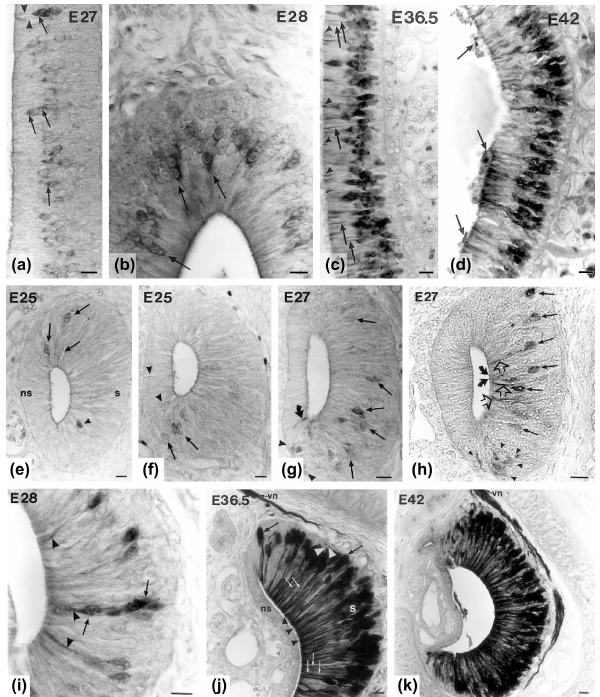
Figure 10. Calretinin immunoreactivity in the developing olfactory epithelium and vomeronasal organ of Tupaia belangeri . (a–d) Ol- factory epithelium from embryonic day (E) 27 to 42. (a) E27: re- ceptor cells (arrows), but not supporting cells (arrowheads) are im- munopositive. (b) E28: strong immunoreactivity in the peri- and supranuclear cytoplasm (arrows) of receptor cells on E28. (c) E36.5: most receptor cells in the mid-zone are immunopositive. Arrows and arrowheads indicate their dendrites and terminal clubs, respec- tively. (d) E42: almost all receptor cells of the mid-zone express calretinin. Arrows, immunoreactivity in the superficial mucus. (e– k) Vomeronasal organ from E25 to E42. (e) E25: immunoreac- tive receptor cells in the sensory (s) epithelium (arrowhead) and in the transition zone to the non-sensory (ns) epithelium (arrows). (f) E25: weak immunoreactivity in presumed ectopic receptor cells in the non-sensory epithelium (arrowheads). Arrows, immunopos- itive receptor cells in the transition zone. (g) E27: the number of immunopositive receptor cells in the sensory epithelium (arrows) has increased. Arrowheads and curved arrows indicate weak im- munoreactivity in basal cells and a presumed ectopic receptor cell, respectively. (h) E27: calretinin expression in clubs (curved ar- rows), dendrites (open arrows), and perikarya (arrows) of receptor cells. Arrowheads, immunopositive cell group at the transition zone. (i) E28: columnar formation (arrows) of immunopositive recep- tor cell perikarya. Arrowheads, receptor cell dendrites. (j) E36.5: immunoreactivity in clubs (arrowheads), dendrites (white arrows), perikarya (black arrows), and axons (white arrowheads) of receptor cells has increased. vn, vomeronasal nerve. (k) E42: calretinin ex- pression in virtually all receptor cells and in the vomeronasal nerve. Scale bars = 10µm in (a–j) ; 20µm in (k) . Reproduced from Malz et al. (2002, Figs. 2b–e, 7). © Springer-Verlag 2002, with kind per- mission from Springer Science and Business